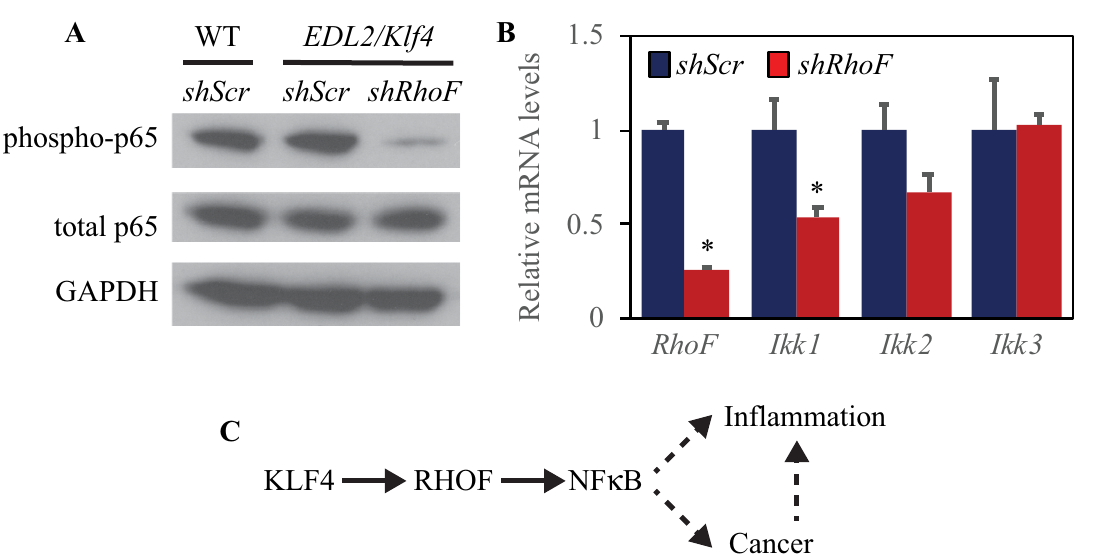
Fig 4. Knockdown of RhoF prevents KLF4-mediated activation NF κ B. ( A ) By Western blot, RhoF knockdown with shRNA blocked p65 phosphorylation in primary esophageal epithelial cells from mice with Klf4 overexpression. ( B ) By qPCR, RhoF knockdown in mouse esophageal epithelial cells with Klf4 overexpression reduced Ikk1 and Ikk2 expression ( � p � 0.05). ( C ) KLF4 upregulates RHOF and increases RHOF activation in esophageal epithelia, leading to NF κ B activation, inflammation, and cancer.